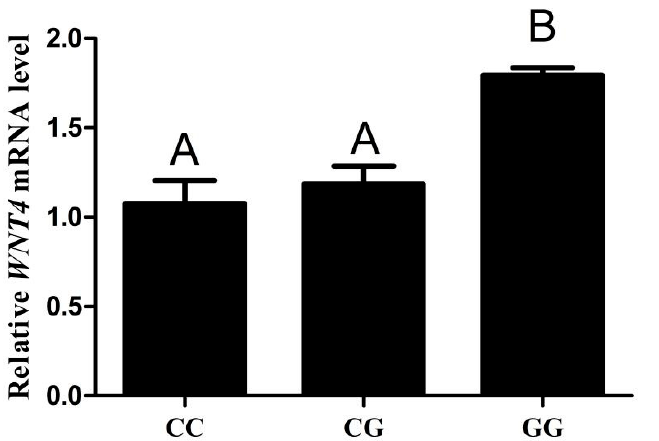
Figure 5. qPCR analysis the mRNA levels of WNT4 in chicken small yellow follicles with genotypes CC, CG and GG ( n = 5). Each bar represents the means ± SEM. Bars with different superscript capital letters (A, B) indicate statistically significant differences at p < 0.01.